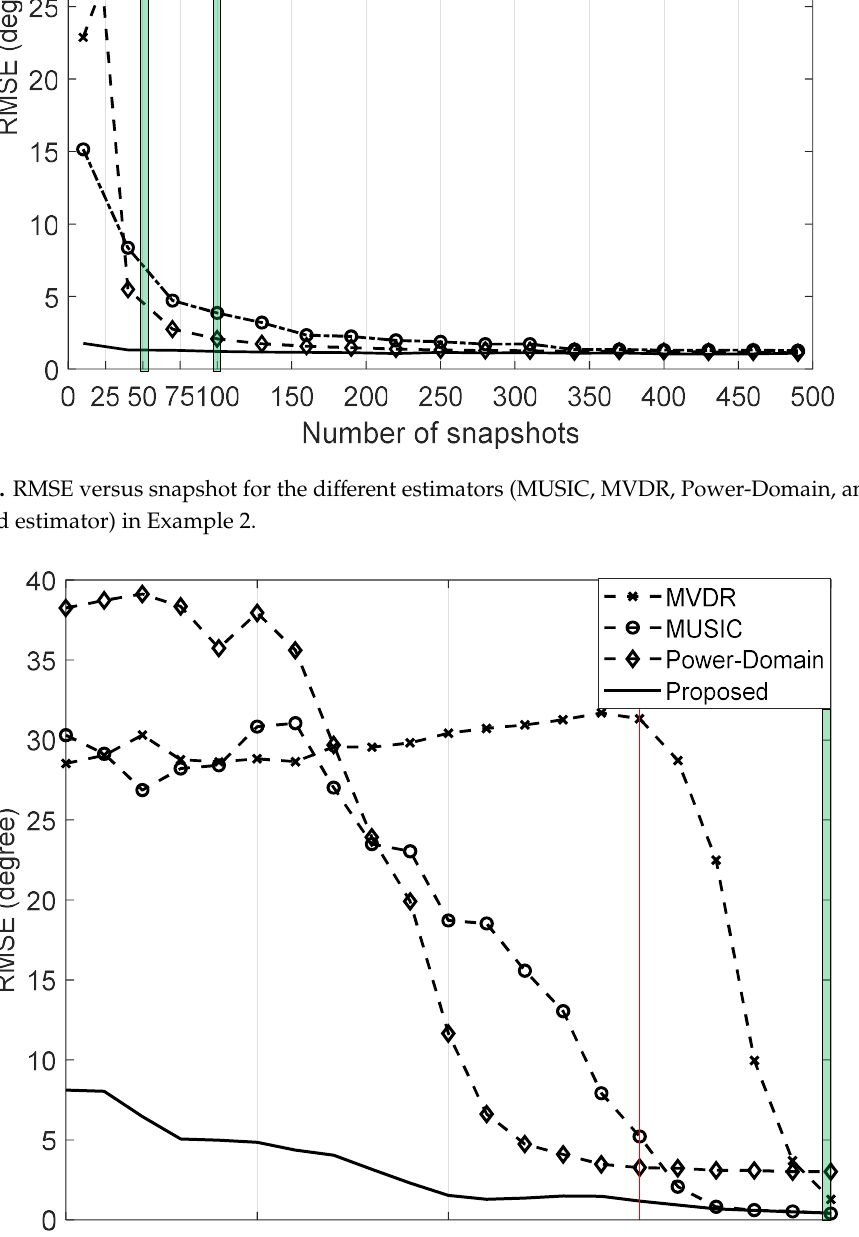
Figure 5. RMSE versus SNR for the different estimators (MUSIC, MVDR, Power-Domain, and the proposed estimator) in Example 2.